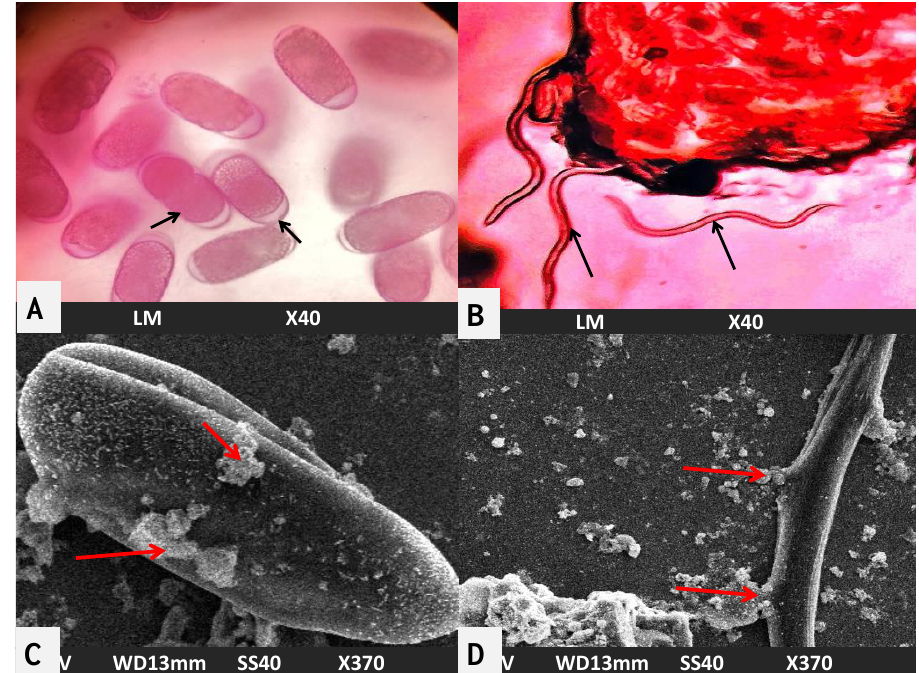
Figure 8. Light microscope images: ( A ). untreated eggs of M. incognita ; ( B ). untreated second-stage juveniles of M. incognita nematode . SEM images of nematode M. incognita treated with AgNPs; ( C ). Eggs; ( D ). second-stage juvenile M. incognita nematode. Red arrows indicate zone of contacts of the AgNPs with the M. incognita eggs and second-stage juvenile nematode.